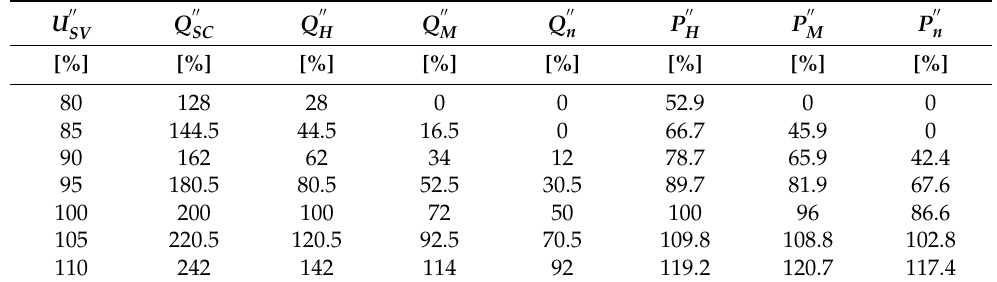
Table 4. Changes of reactive and active power of the arc device for different values of the supply